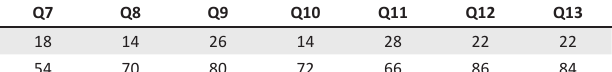
TABLE 1: Results from the mathematical problem-solving skills inventory. Test